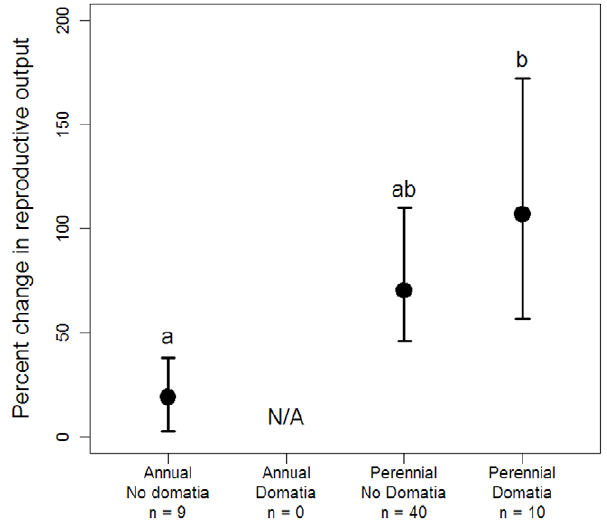
Figure 3. Benefits of ant presence varied according to plant life history and presence/absence of domatia. Predicted mean percent changes ( 6 1 SE) in reproductive output when ants are present for the three combinations of domatia production and life history present in the dataset. Effects of domatia and life history combinations are population marginal means averaged over the effects of observational and experimental studies. Letters indicate significant pairwise differences (p , 0.05) between groups based on Tukey’s post- hoc multiple comparisons of means.